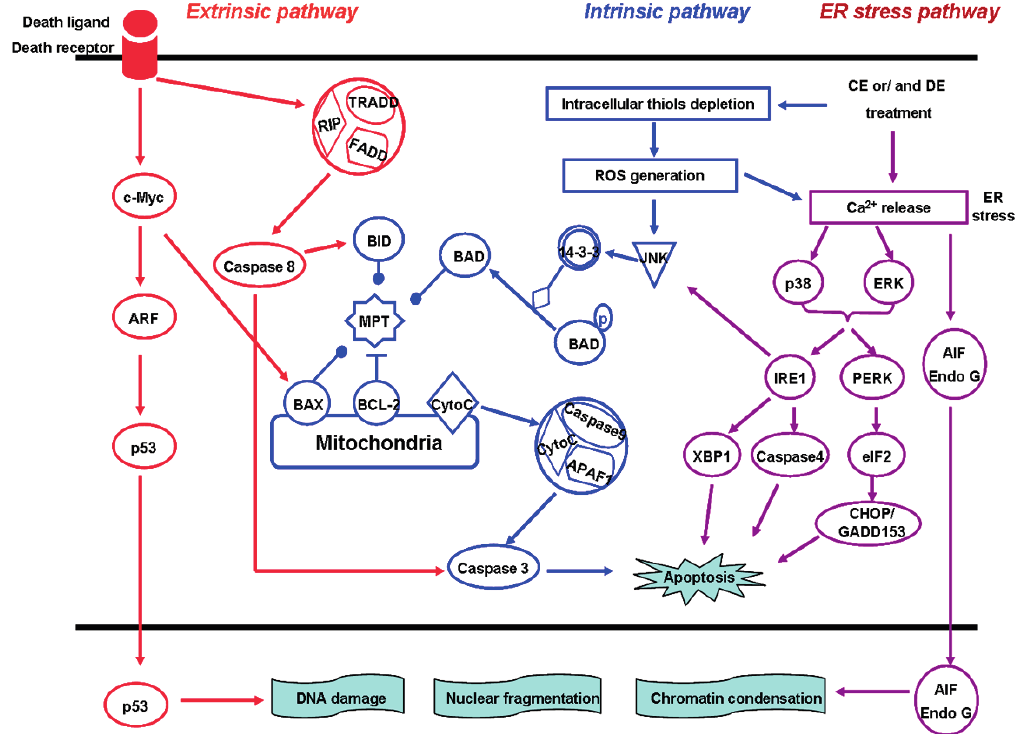
Figure 3. Costunolide (CE) or/and Dehydrocostuslactone (DE)-induced cell